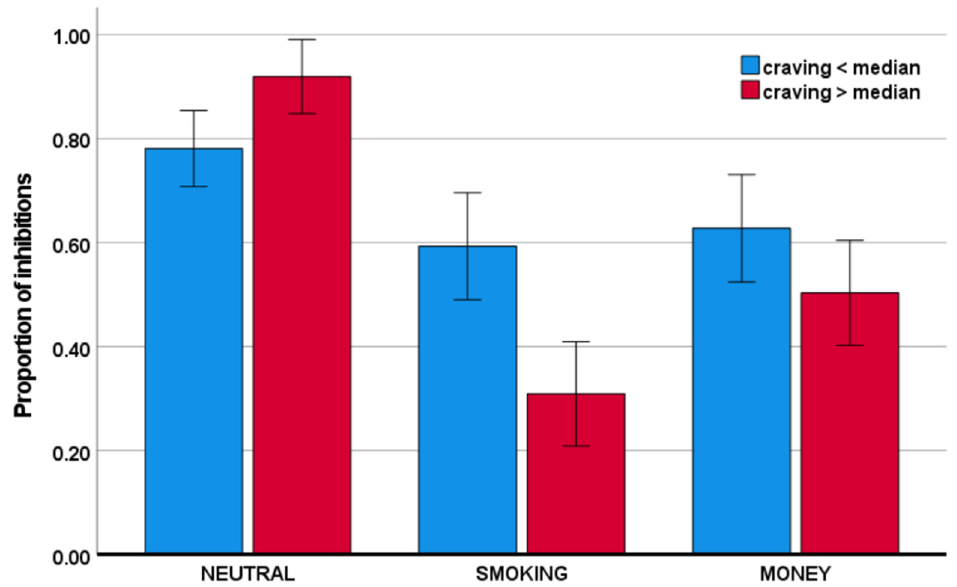
Figure 4. Proportion of inhibitions as a function of craving across conditions.